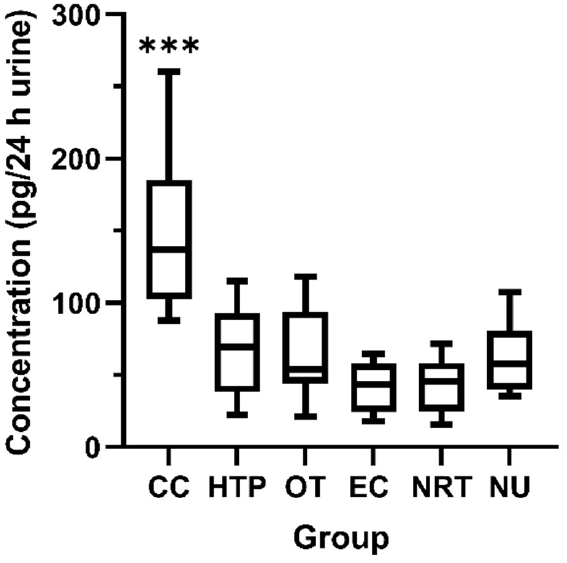
Figure 4. Box plots for urinary 3-OH-BaP excretion (pg/24 h) of six different user groups on Day 3. Boxes and lines represent the range of twenty-fifth/seventy-fifth percentile and the median value. The whiskers illustrate the minimum and maximum concentration. Differences between the smoking (CC) and all other groups were found to be significant when using the non-parametric Mann–Whitney U test (***: p -value < 0.002). Table 4. Descriptive statistics for urinary 3-OH-BaP excretion (pg/24 h) of six different user groups.